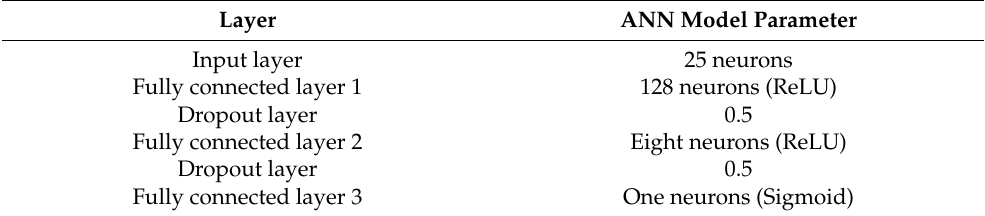
Table 4. Details of the ANN model.